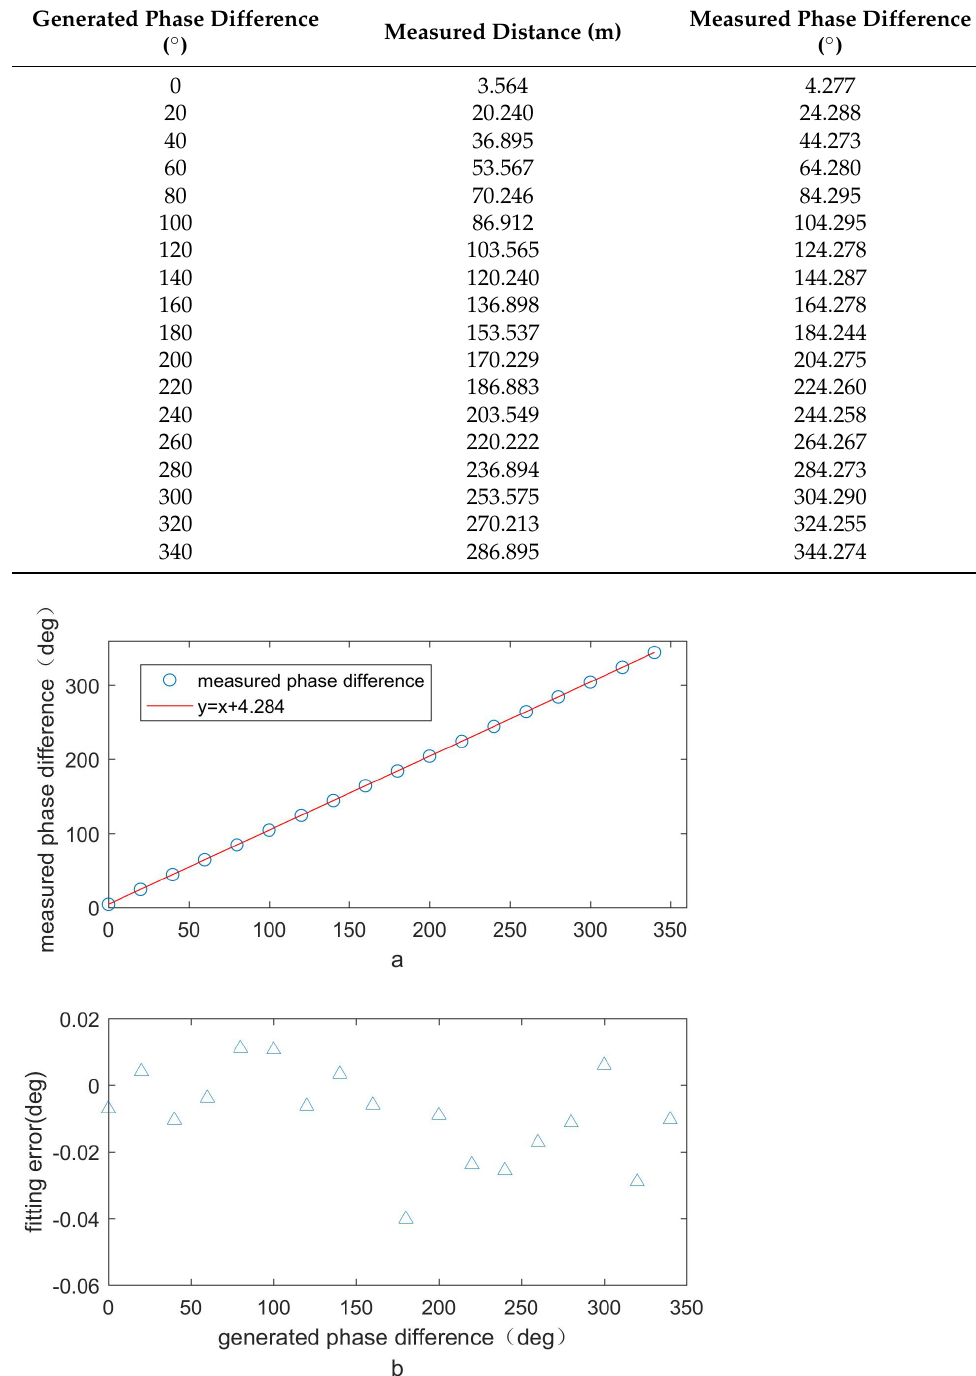
Table 1. Generated and measured phase differences ( ◦ ).